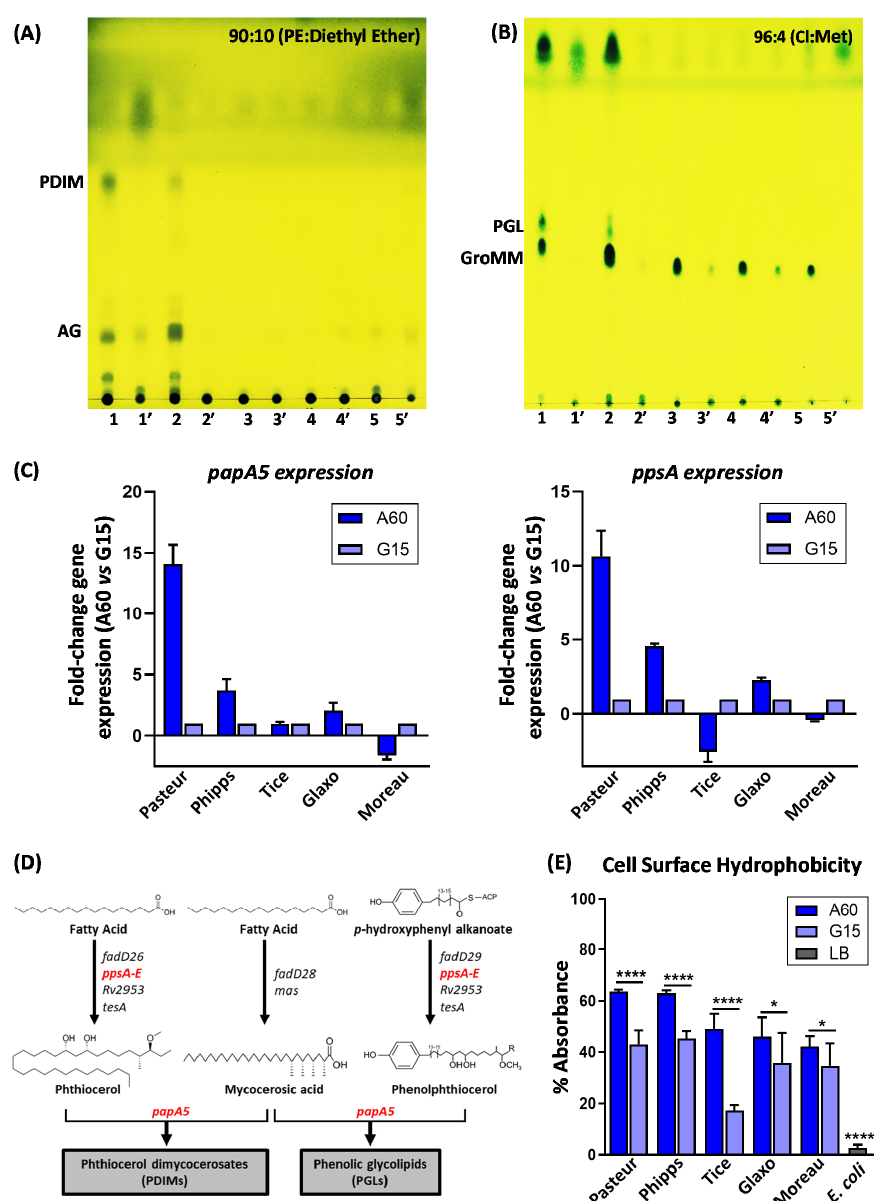
Figure 1. Analyses of the outermost surface of BCG substrains. ( A , B ) Thin-layer chromatography (TLC) corresponding to the superficial lipids extracted using petroleum ether (PE) at 40–60 °C for 5 min of BCG substrain pellicles grown on A60 and G15 Sauton media. The volume of lipid extracts applied to TLC plates was equal under all conditions and derived from the same pellicle surface. The results of one representative experiment out of at least three biological replicates. TLC elution was performed ( A ) in PE:diethyl ether at 90:10 ( v / v ) or ( B ) in chloroform:methanol at 96:4 ( v / v ). Both plates were treated with 10% molybdatophosphoric acid in ethanol. BCG-Pasteur (Lines 1 and 1 (cid:48) ); BCG-Phipps (Lines 2 and 2 (cid:48) ); BCG-Tice (Lines 3 and 3 (cid:48) ); BCG-Glaxo (Lines 4 and 4 (cid:48) ); and BCG-Moreau (Lines 5 and 5 (cid:48) ). 1-5 BCG substrains grown on A60 Sauton medium and 1 (cid:48) -5 (cid:48) BCG substrains grown on G15 Sauton medium. ( C ) Fold ratio of papA5 and ppsA expression in BCG substrains grown on A60 medium relative to that of BCG substrains grown on G15 medium. ( D ) Scheme of genes involved in PDIM and PGL synthesis. ( E ) Affinity of BCG substrains towards hexadecane, E. coli was used as a negative control. The results are expressed as a percentage of the initial absorbance at 400 nm. appearance. Data represent the mean ± standard deviation (SD) from three independent experiments. * p < 0.05, **** p <0.0001 (ANOVA